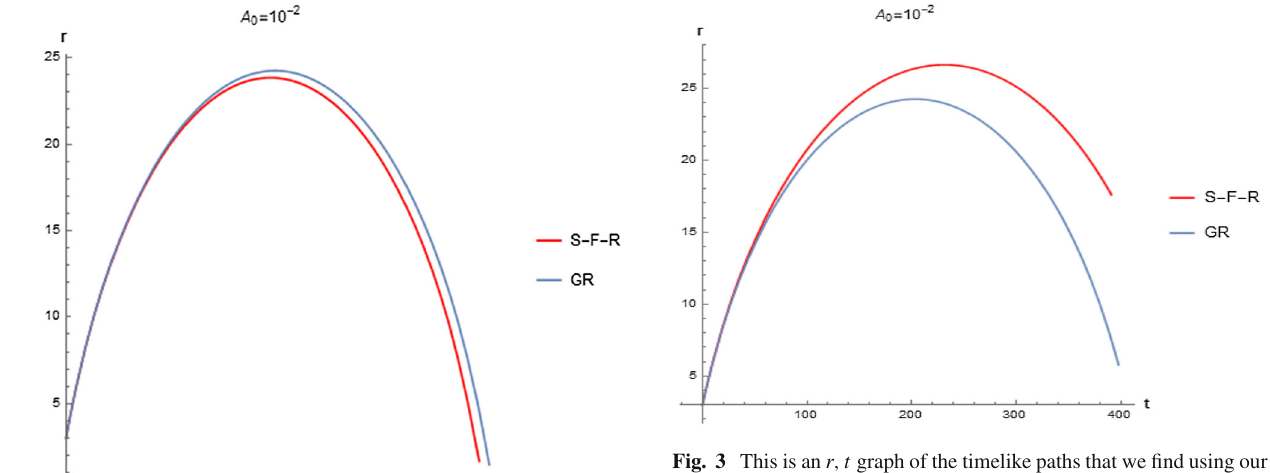
Fig. 3 This is an r , t graph of the timelike paths that we find using our